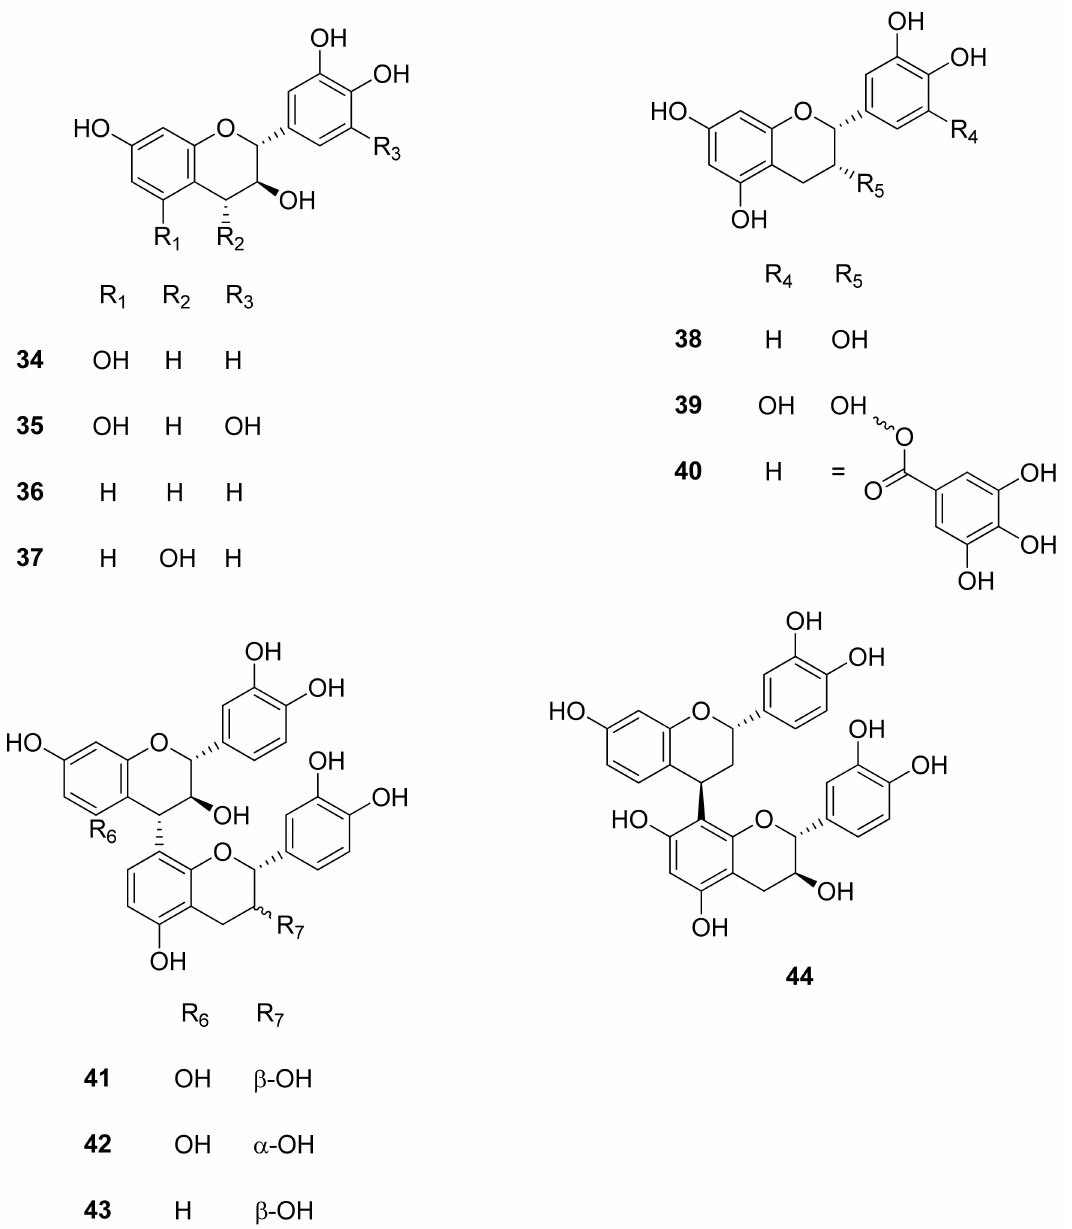
Figure 4. Structures of proanthocyanidin monomers and dimers from genus Rhoicissus . A phytochemical investigation of the roots and fruits of R. digitata led to the isolation of triterpenes and flavonoids [44]. From the roots, leaves, and fruits of R. tomentosa , terpenoids, flavonoids, an alkaloid, and a carotenoid were isolated, as illustrated in Table 5 and Figure 3 [44]. Moreover, the leaf extracts of R. tomentosa tested positive for coumarins, flavonoids, phytosterols, essential oils, saponins, terpenoids, and resveratrol, and the hexane and ethyl acetate/hexane (1:4) extracts of R. tomentosa were submitted for GC–MS analysis